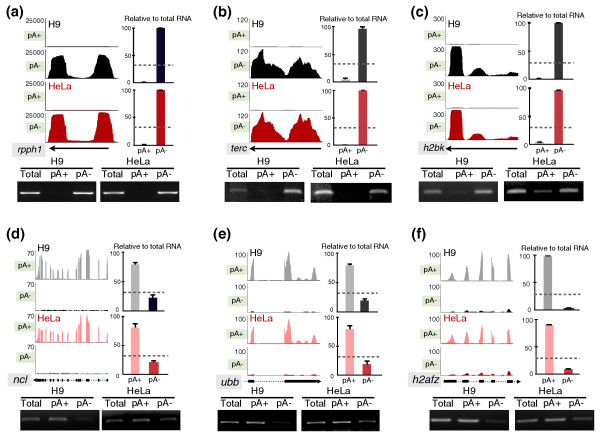
Validation of selected poly(A)+ and poly(A)- transcripts. (a-c) Validation of known poly(A)- transcripts. Y-axis: normalized read densities of each gene from the UCSC genome browser (left panels). Quantitative RT-PCR (qRT-PCR) was performed with independent poly(A)+ and poly(A)- sample preparations, and the relative signals from each enriched RNA preparation were normalized to those in the total RNA preparations from different cell lines (right panels). Note that the signals for poly(A)- transcripts were significantly enriched in the poly(A)- samples. (d-e) Validation of known poly(A)+ transcripts. Normalized read densities (left panels) and qRT-PCRs (right panels) were analyzed as described above. Note that the signals for poly(A)+ transcripts were significantly enriched in the poly(A)+ samples. Grey, poly(A)+ sample from H9 cells; black, poly(A)- sample from H9 cells; pink, poly(A)+ sample from HeLa cells; red, poly(A)- sample from HeLa cells. Dashed lines, the cutoff ratio used to assign poly(A)+ and poly(A)- transcripts (the abundance in either poly(A)+ or poly(A)- fractionation accounts for more than one-third when compared to the total RNA). Gene models are shown beneath the UCSC genome browser screenshots. See text for details. These descriptions are also used for other figures throughout this study. Error bars were calculated from three biological repeats.